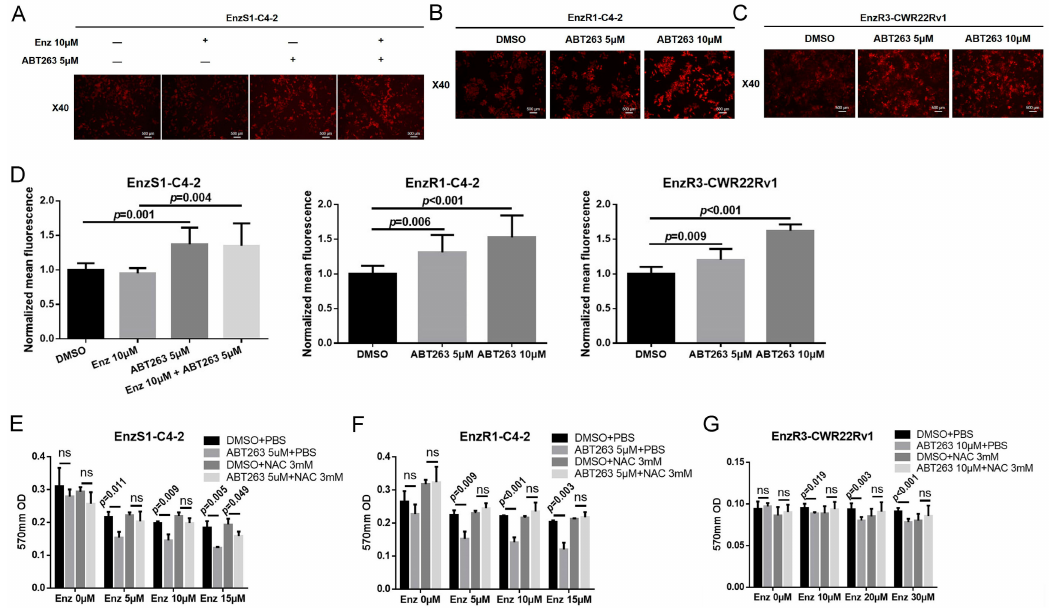
Figure 3. ABT263 increases Enz sensitivity through inducing cellular ROS. ( A – D ) ABT263